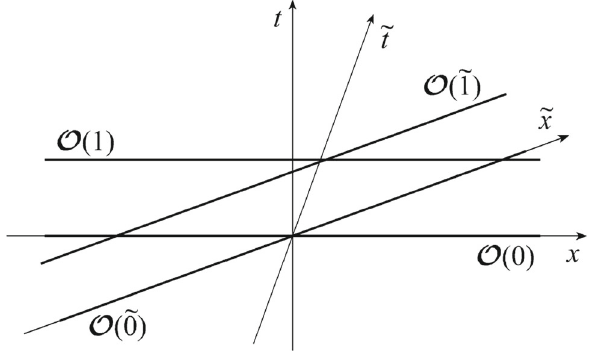
Fig. 1 Operators constructed by integrating local fields over spacelike surfaces cannot in general have simple transformation properties under Lorentztransformationssince O ( 0 ) transformsto ˜ O ( 0 ) andnotto ˜ O ( ˜ 0 ) , which is the transform of O ( ˜ 0 ) . That will happen only if O ( 0 ) = O ( ˜ 0